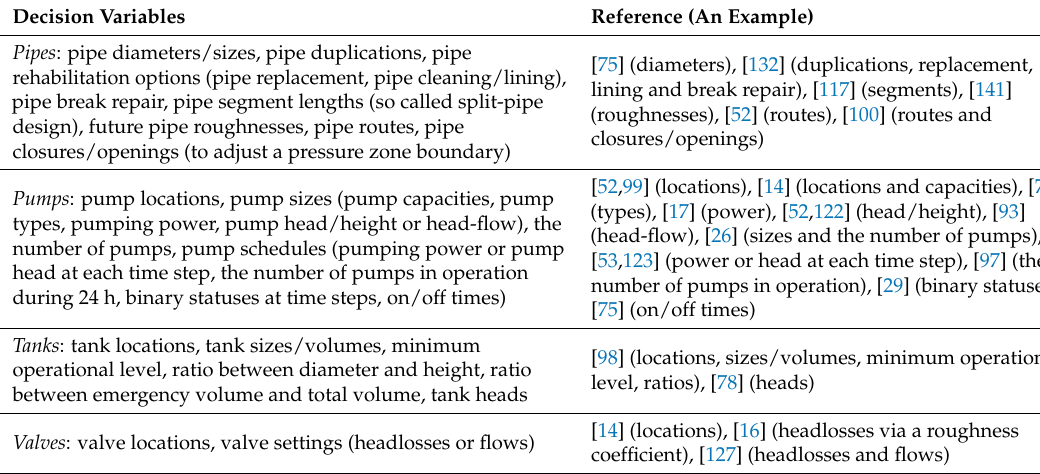
Table 3. Decision variables of a general optimisation